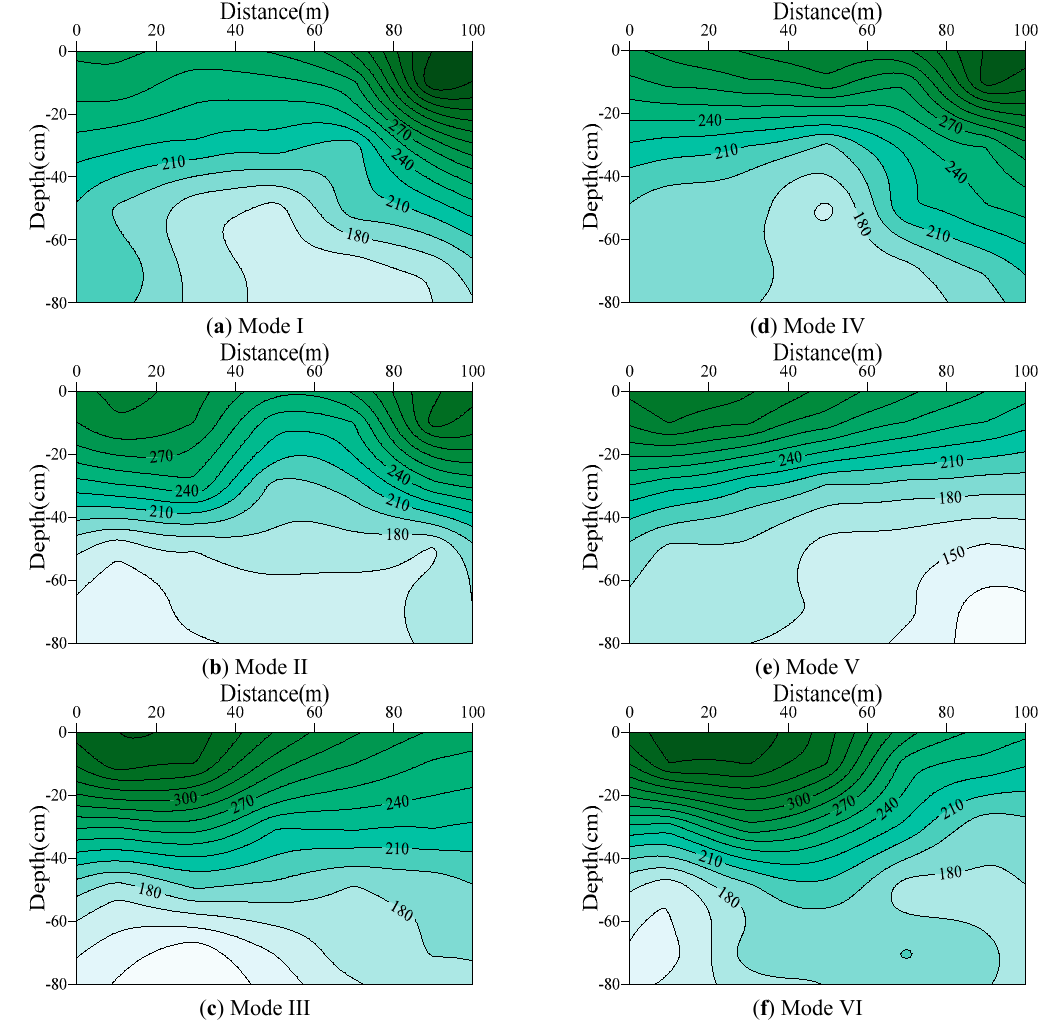
− concentration in the soil 2 days after concentration in the soil 2 days 4 4